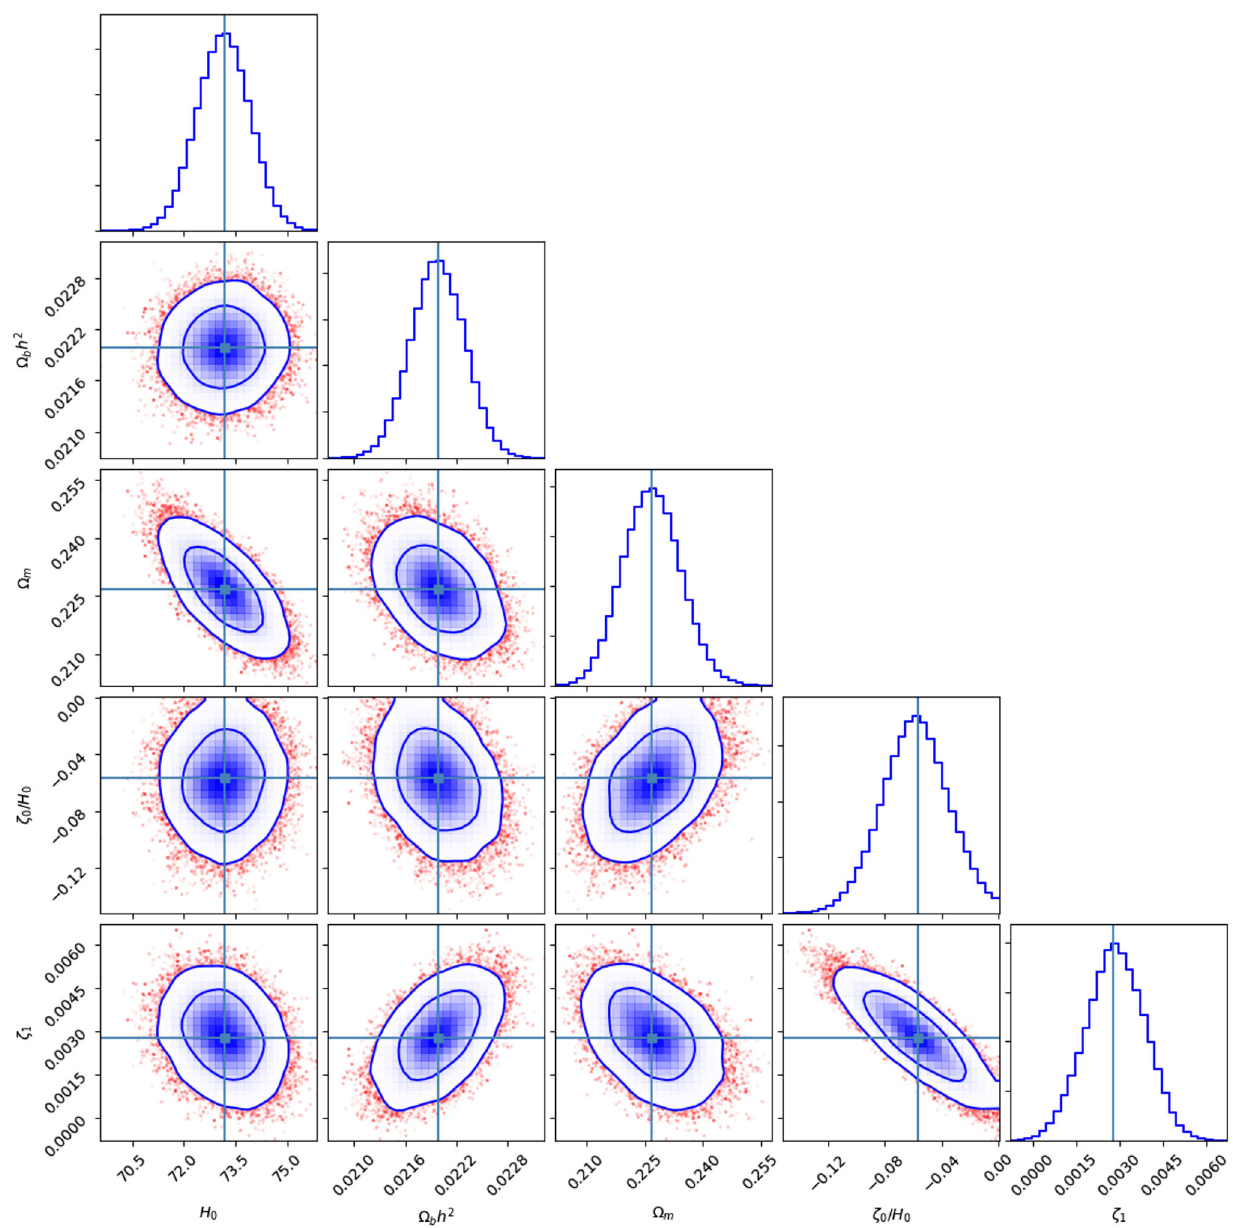
Fig. 1 Constraints on the parameters from 1 σ to 2 σ confidence level obtained by the fitting